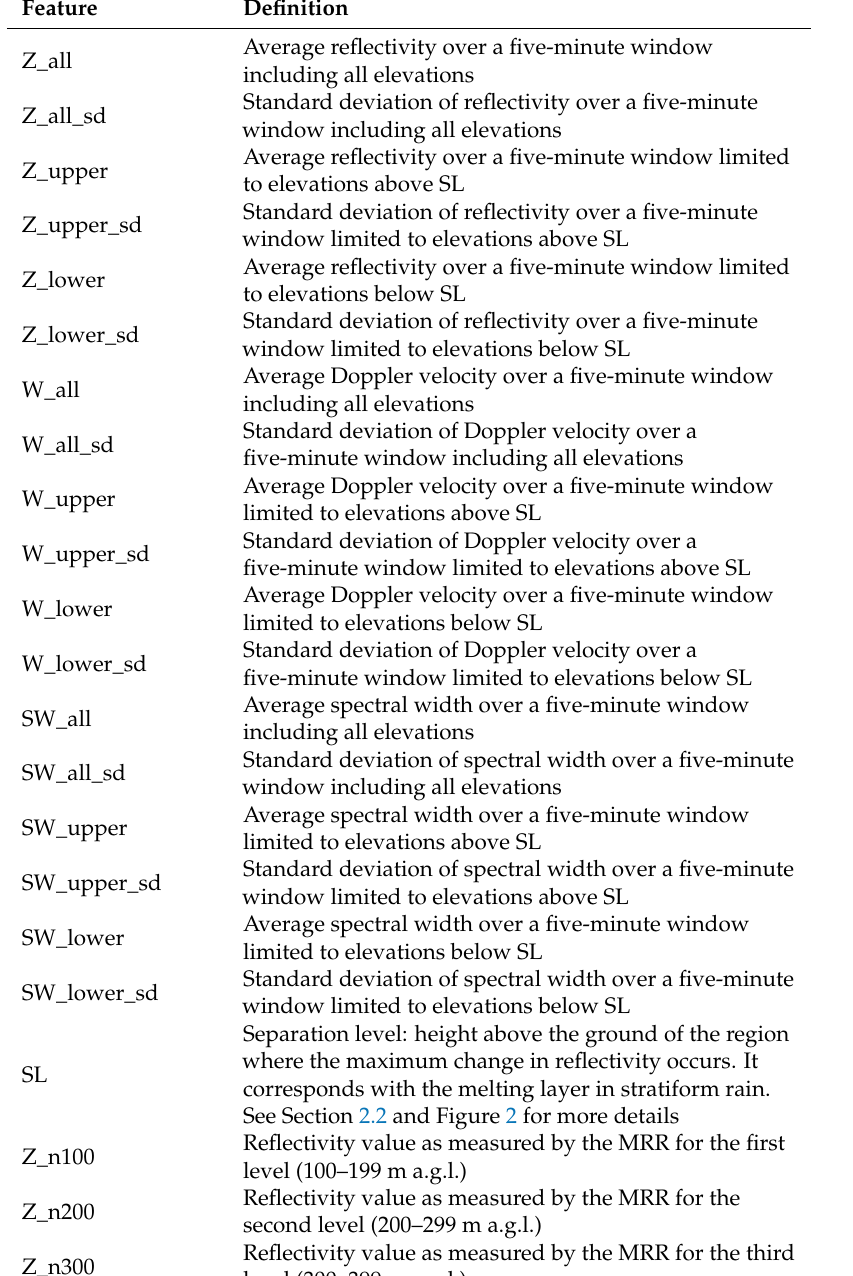
Table A1. A short description of each of the 22